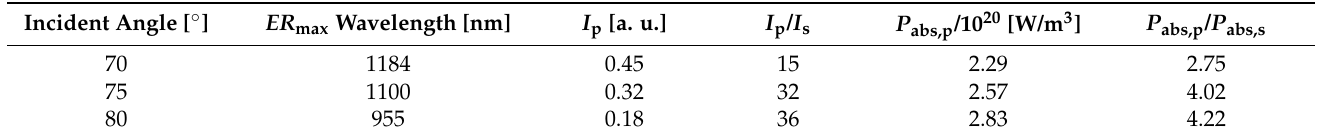
Figure 5. The mechanism for incident-angle-modulation near-infrared polarizer based on SnSe ( d SnSe = 315 nm)-SiO 2 ( d SiO = 675 nm)-Si multilayer structure. The contour maps of electric field 2 intensity of ( a , e , i ) s and ( c , g , k ) p light ( I s and I p ) and absorbed power of ( b , f , j ) s and ( d , h , l ) p light ( P abs,s and P abs,p ) at the incident angle of 70 ◦ /75 ◦ /80 ◦ , respectively, and I p and P abs,p is at the corresponding ER max wavelength. Table 2. The average SnSe’s I p and P abs,p , with their ratio to I s and P abs,s , respectively, at high incident angle and ER max